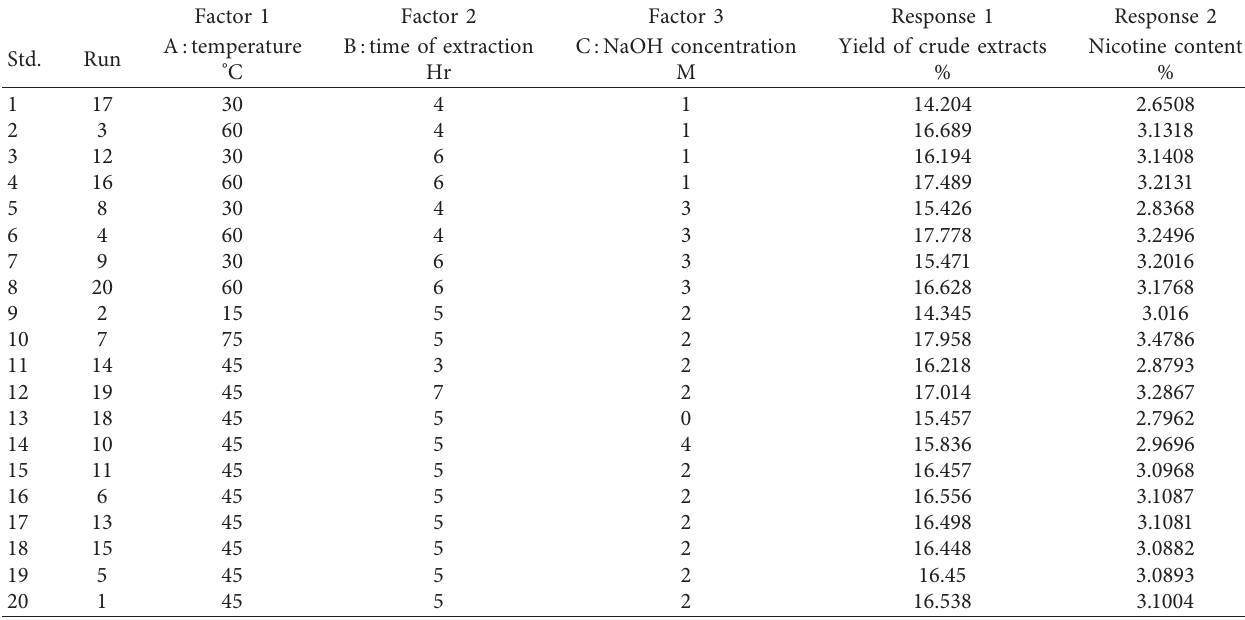
Table 4: Designed variables were analyzed by central composite